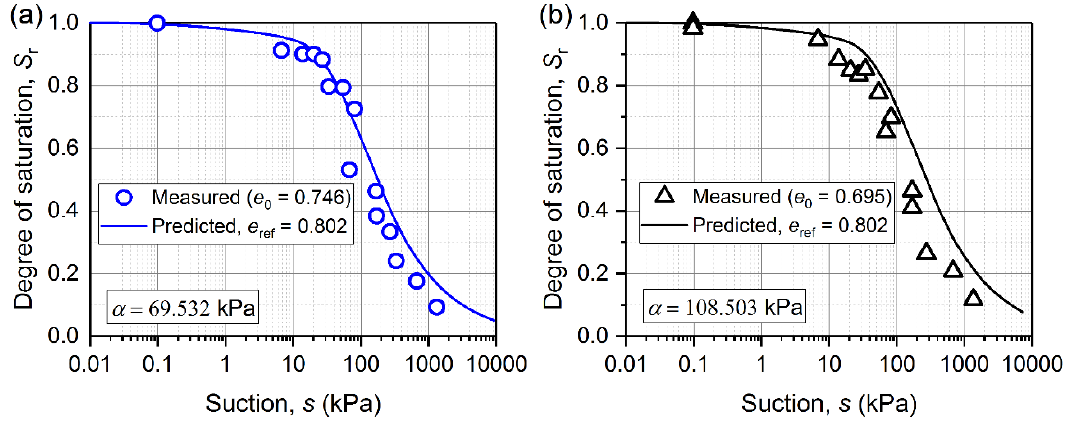
Figure 7. Measured and predicted SWRC for a tailing sand at ( a ) e 0 = 0.746; ( b ) e 0 = 0.695.